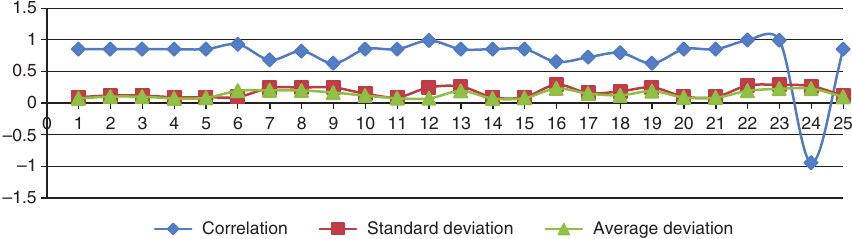
Figure 10: Lee et al. [21] Data Set – Result Analysis for Classes 2–3 Scores.